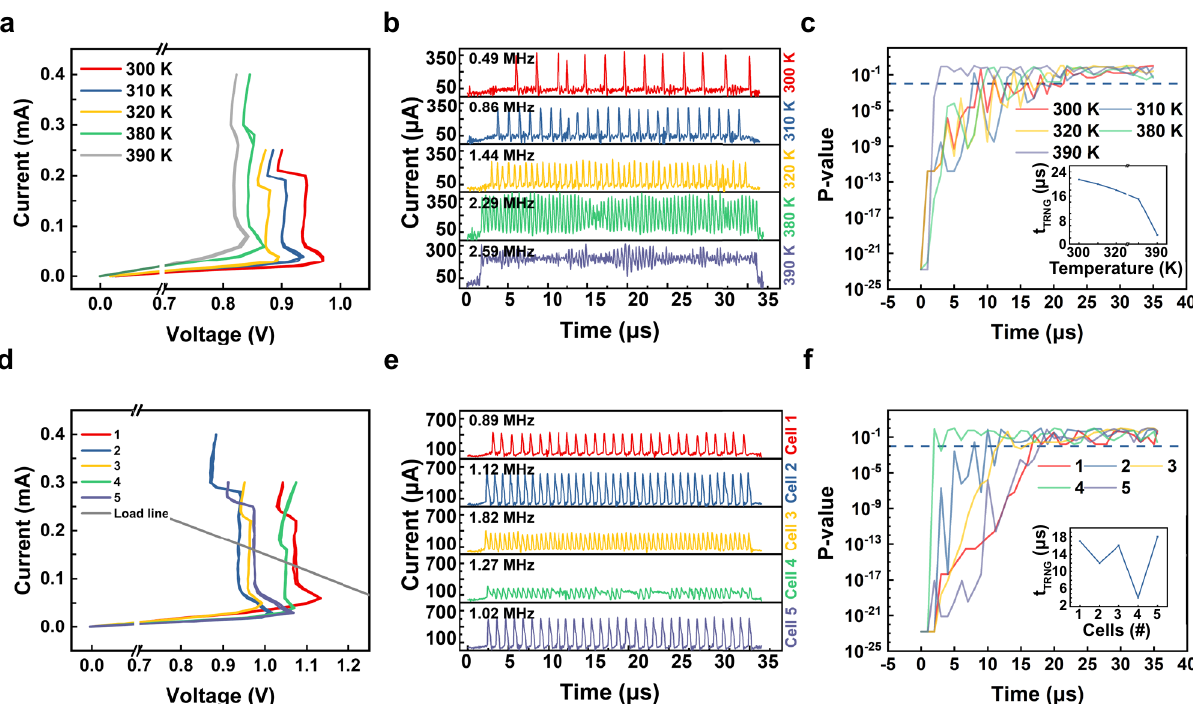
Fig. 5 Variation tolerant test results at different ambient temperature and at different cells. a The I – V curves at different temperatures from 300 K to 390 K from the same cell. b The oscillation current outputs at different temperatures. The frequency of oscillation increases as the temperature increases at the identical input voltage pulse. c The P value of the monobit test as a function of the input voltage pulse time using 100 bits per each temperature. The random bit reference line of 0.01 is included. The inset shows the minimum pulse time for random number generation as a function of the temperature. d Representatively distinguishable I – V curves from fi ve different cells. e The oscillation current outputs and their frequency from each cell. f The P value for the monobit test obtained from 100 bits collected from each cell. They all pass the test at different random number generation time as shown in the